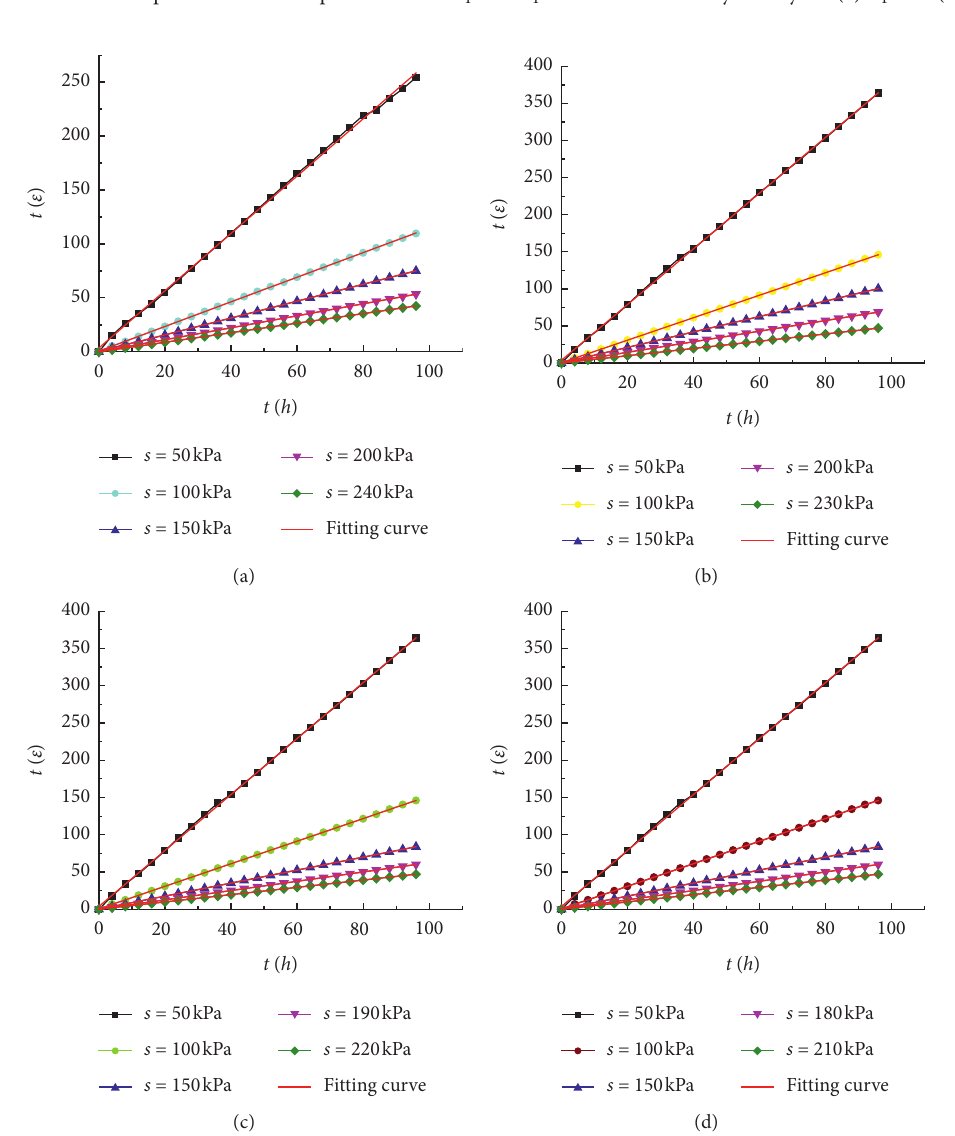
Figure 9: Curves between t / ε and t under different initial static deviator stress. (a) q � 0kPa, (b) q � 10kPa, (c) q � 15kPa, and (d) q �